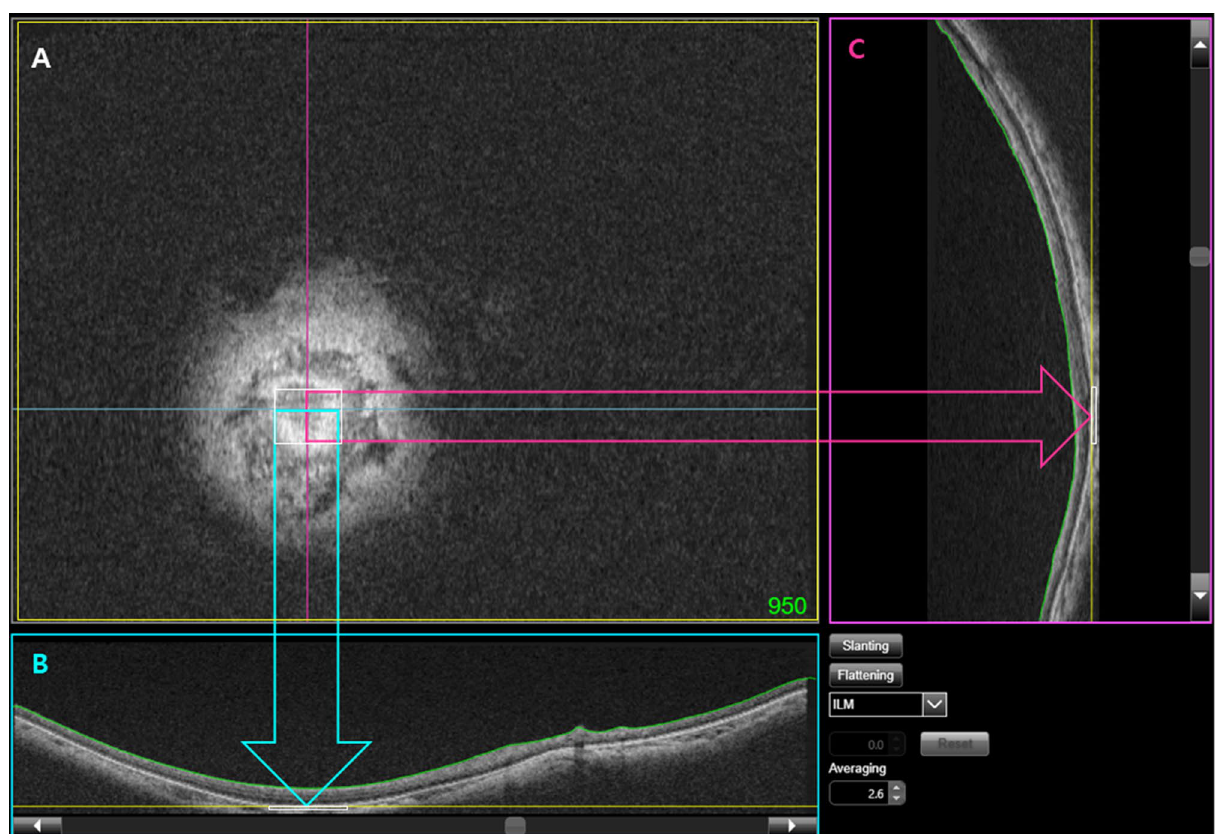
Figure 3. Designation of the deepest point of the eye (DPE) using the coronal ( A ), horizontal ( B ), and vertical ( C ) scan. The specific coronal section (given in green numbers in the ( A )) that simultaneously displayed the coronal view of the hyperreflective Bruch’s membrane (white square) in all three displays ( A – C ) was designated as the DPE position.